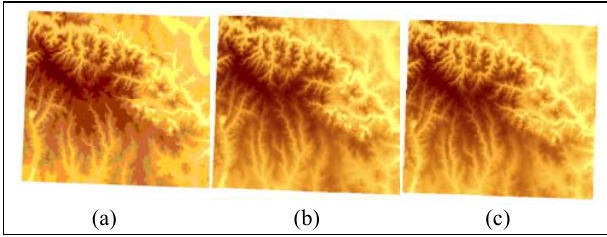
Figure 2. DEM data set DEM1000 (a), DEM5000–30 (b), DEM5000–5 (c)